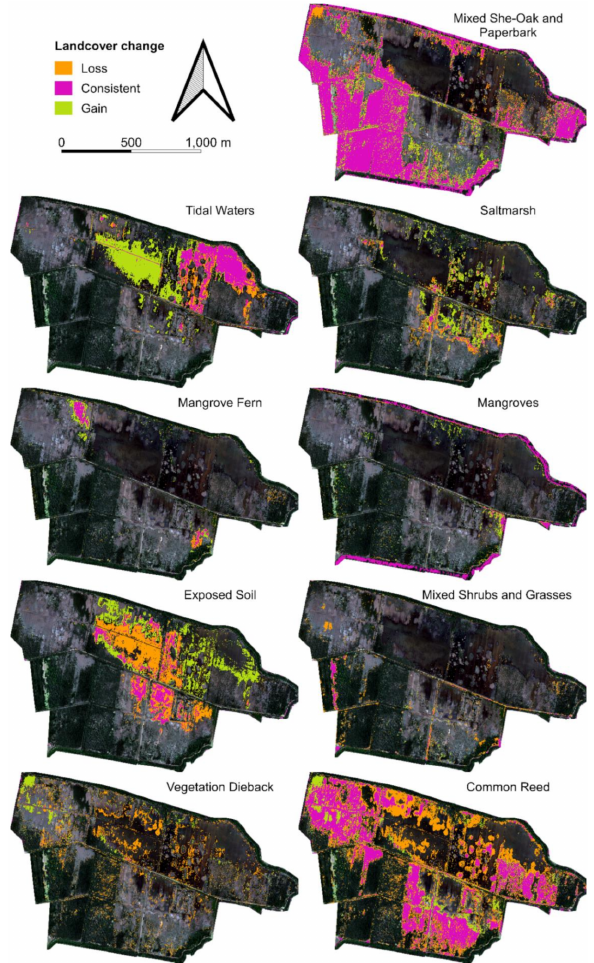
Figure 6. Spatial distribution of changes in the nine land cover classes between spring 2017 and